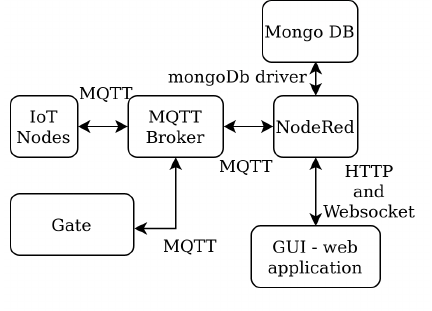
Figure 2. The main system data